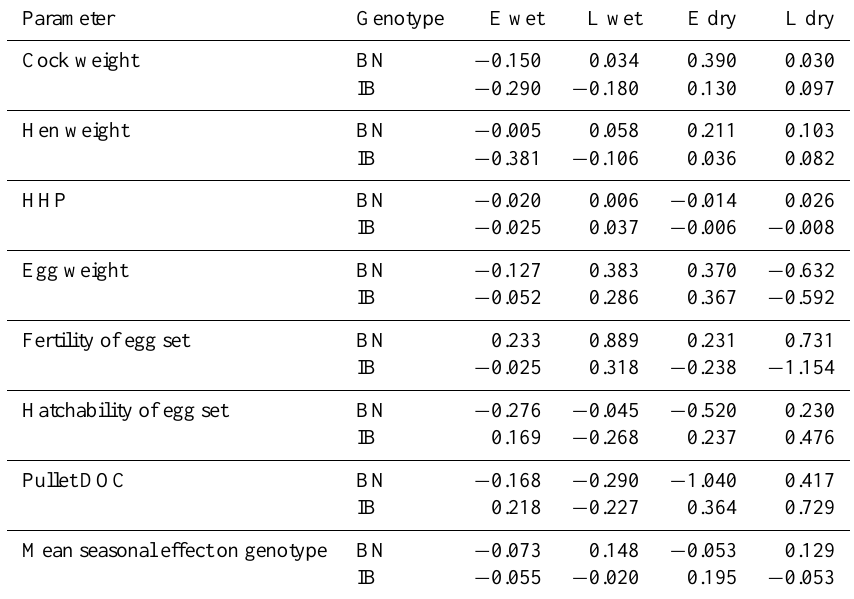
Table 5. Seasonal (sensitivity) effect on Bovan Nera and ISA Brown genotypes classified by traits. Parameter Genotype E wet L